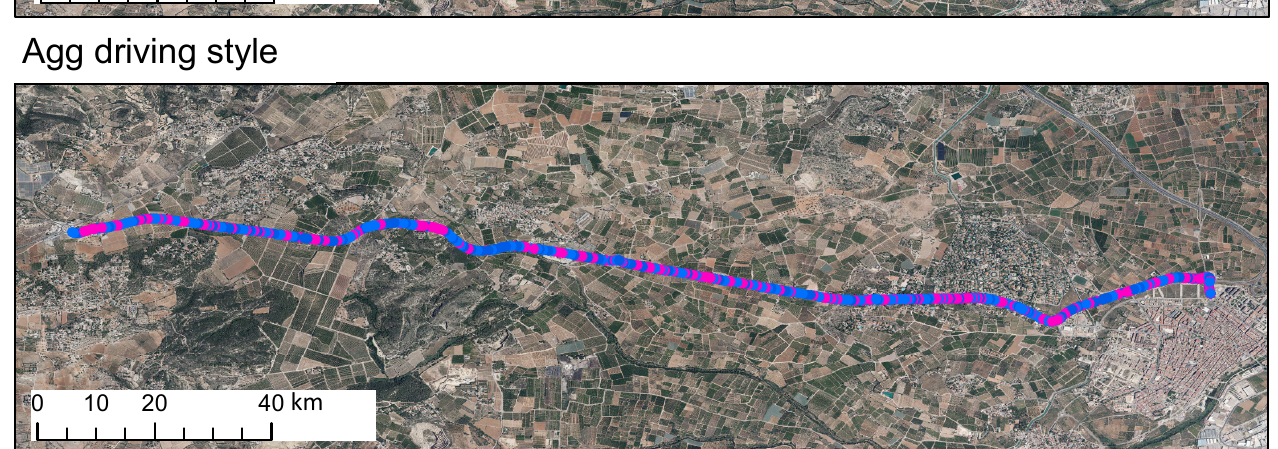
Figure 8. Variation of fgx along the route for the three driving patterns.